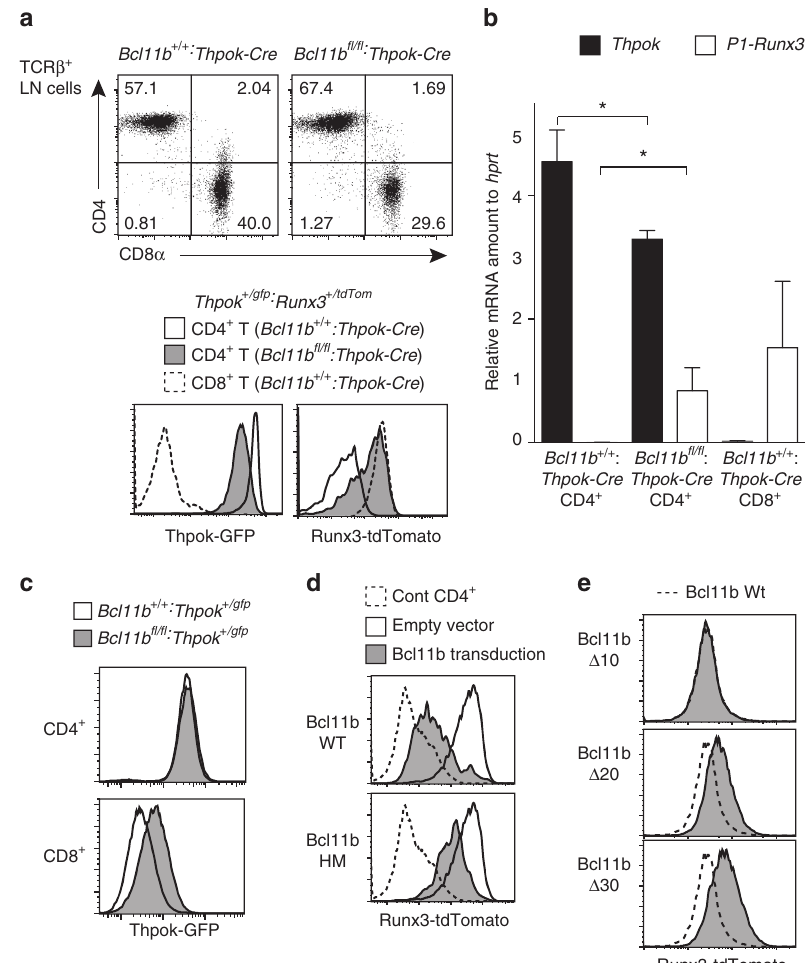
Fig. 6 Bcl11b function requires its C-terminal zinc- fi nger motif. a Flow cytometry analyzing the expression of CD4, CD8, Thpok-GFP, and Runx3-tdTomato in peripheral T cells from Bcl11b + / + :Thpok-Cre and Bcl1b fl / fl :Thpok-Cre mice harboring Thpok gfp and Runx3 tdTomato reporter genes. Inactivation of Bcl11b during the maturation of CD4-lineage cells by a Thpok-Cre transgene resulted in impaired Thpok-GFP expression, as well as Runx3-tdTomato de-repression. b RT- qPCR analyses showing relative amounts of Thpok (black bars) and P1-Runx3 (white bars) mRNA in splenic CD4 + CD8 − T cells of Bcl11b + / + :Thpok-Cre and Bcl11b fl / fl :Thpok-Cre mice. Results in splenic CD4 − CD8 + T cells of Bcl11b + / + : Thpok-Cre are shown as references. Data were summary of three experiments. Means ± SD * P < 0.05 (unpaired t -test). c Histograms showing Thpok-GFP expression from CD4 + and CD8 + T cells of Bcl11b + / + :Thpok + /gfp (white bars) and Bcl11b fl / fl :Thpok + /gfp (gray bars) mice 4 days after retroviral Cre transduction. One representative of three experiments. d Histograms showing Runx3- tdTomato expression 3 days after retroviral transduction of Wt and hypomorphic (HM) Bcl11b into peripheral CD4 + CD8 − Runx3-tdTomato + cells from Bcl1b fl / fl :Runx3 + /tdTomato :Thpok-Cre mice. Expression of Runx3-tdTomato in activated control CD4 + T cells ( dotted line ) after transduction with an empty vector ( open ) are shown as controls. e Histograms showing Runx3-tdTomato expression after retroviral transduction of mutant Bcl11b proteins lacking the C-terminal zinc- fi nger motif are shown as in d . The dotted line represents Runx3-tdTomato expression after transduction of Wt Bcl11b. One